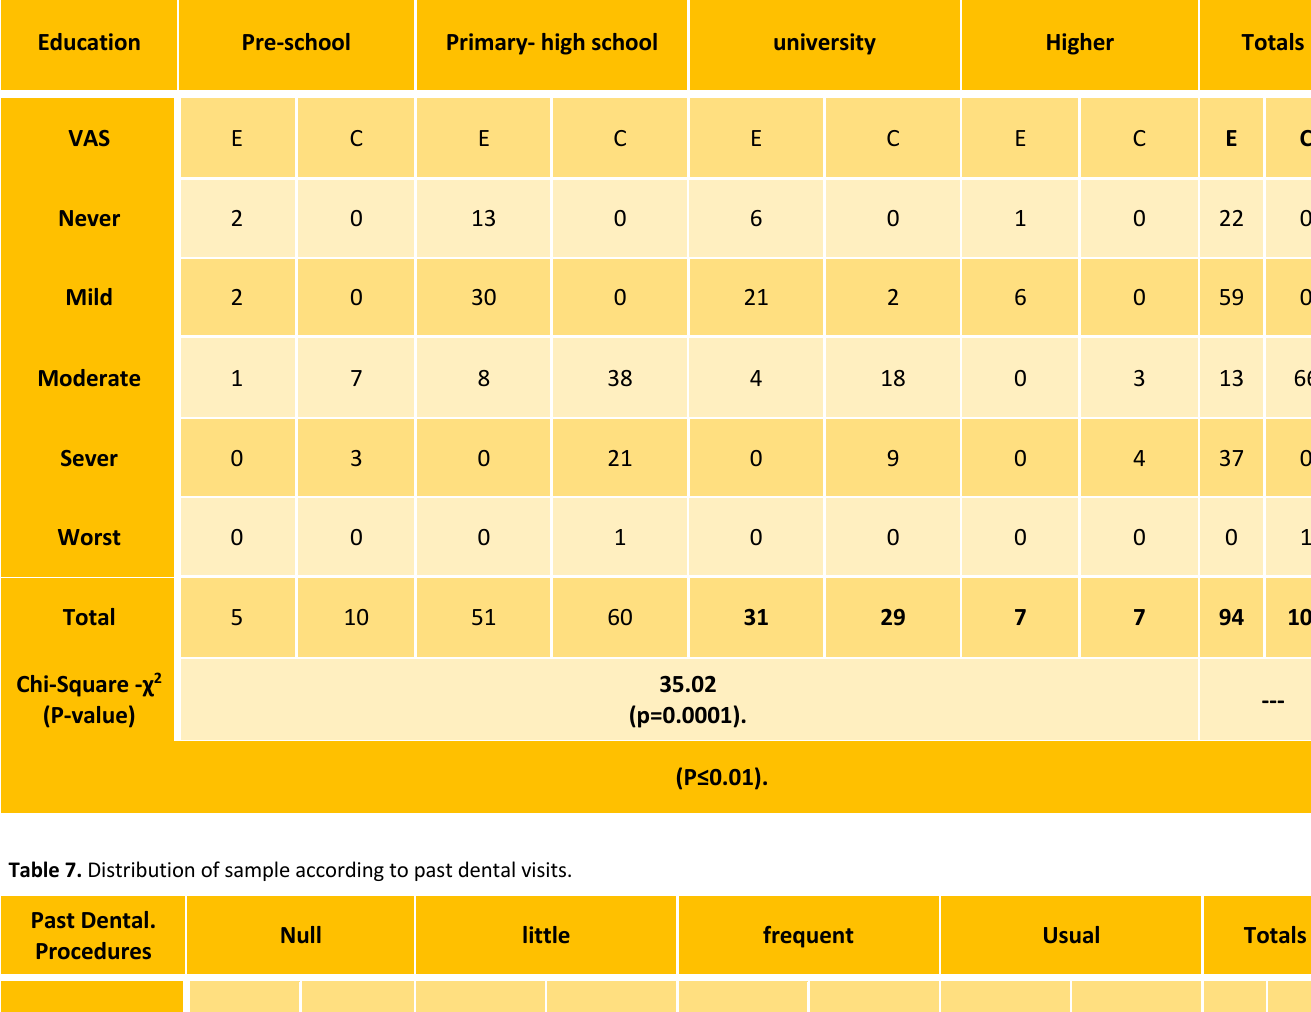
Table 6. Distribution of sample according to Education/VAS/E&C.